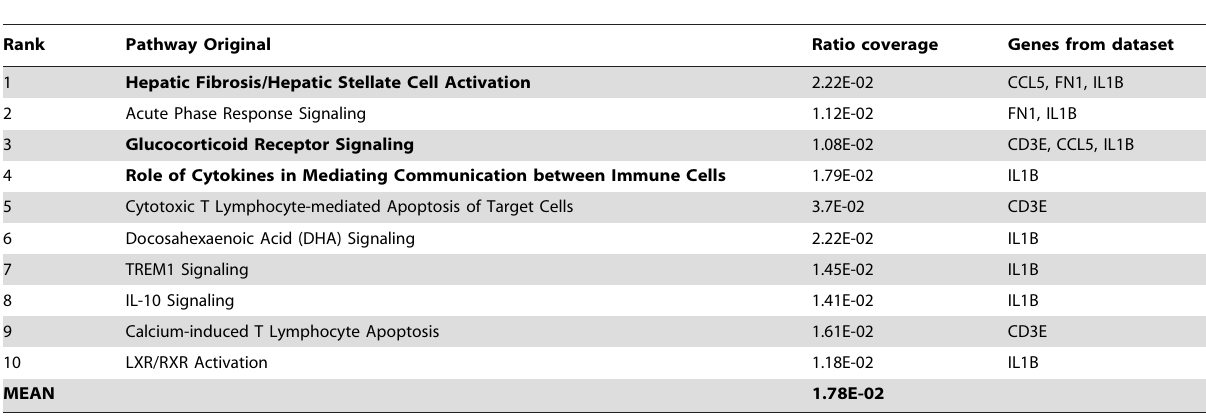
Table 5. Top 10 significant pathways original differentially expressed mRNA dataset.